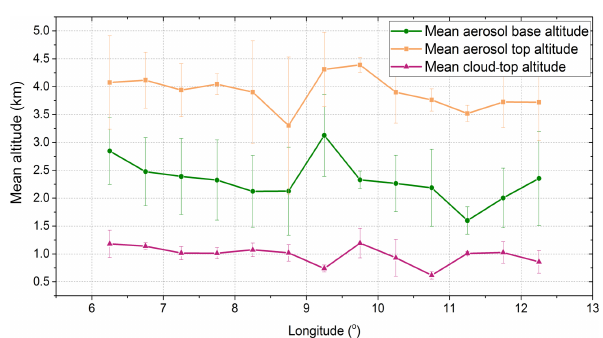
Figure 5. Mean cloud-top altitude, aerosol base altitude and aerosol top altitude retrieved with CALIOP operational product, as a func- tion of longitude, between 6 and 13 ◦ E for June–August 2008. Ver- tical bars represent the standard